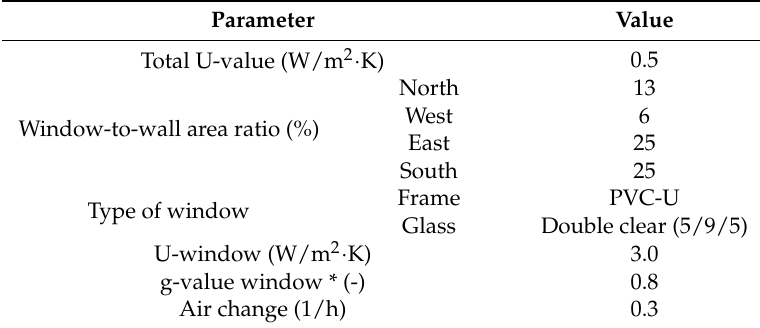
Figure 3. The tourist center and the office building marked with the red frame, which the solar cooling system serves.